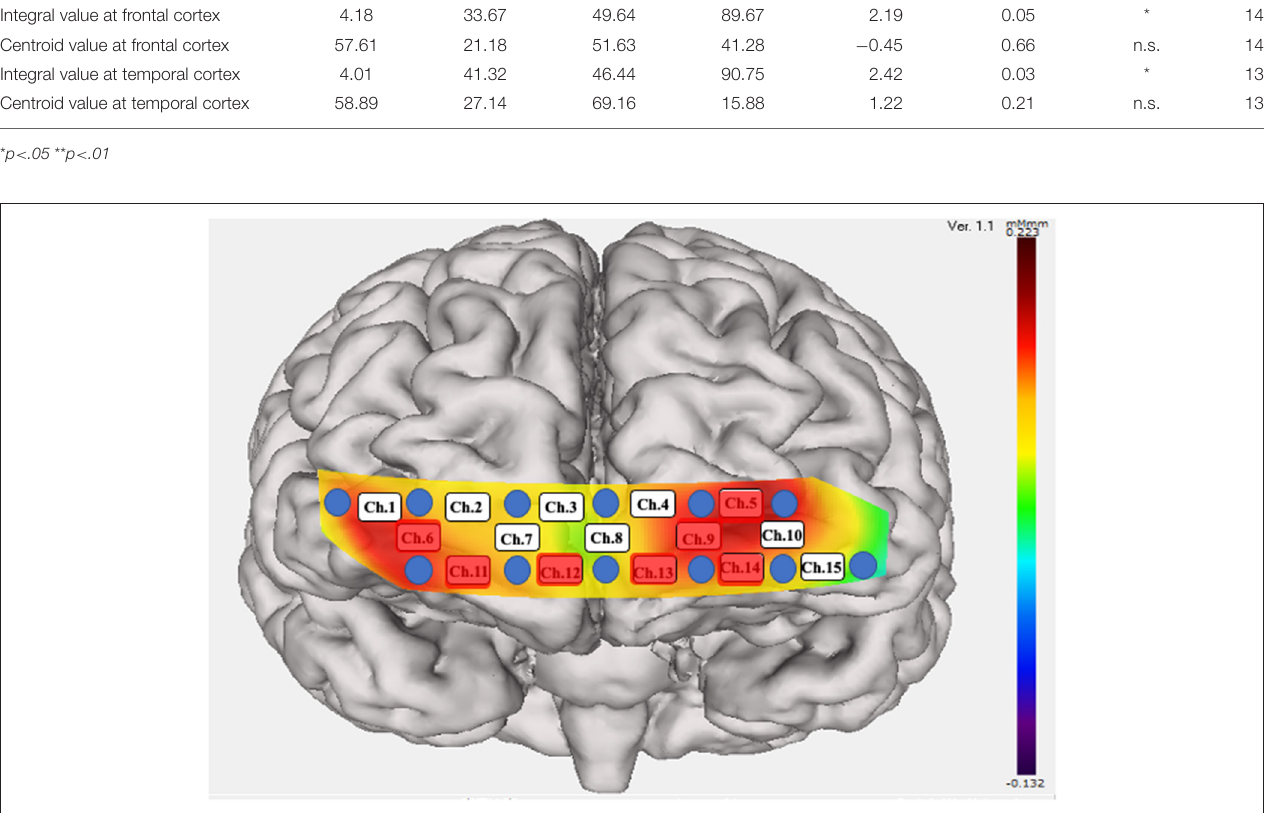
FIGURE 4 | Significant increase in the integral value of blood flow. Twelve probes (lowest probes according to the Fp1–Fp2 line) were placed on the anterior brain. Fifteen channels were divided into temporal (Ch. 1, 6, 10, and 15) and frontal (the remaining channels) positions. A significant increase in blood flow was seen in the red colored